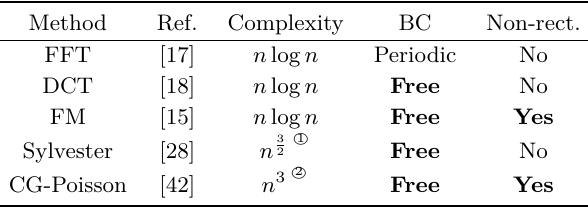
Comparison of five existing fast and accurate surface normal integration methods based on three criteria: their algorithmic complexity w.r.t. the number n of pixels inside the computational domain Ω (the lower the better), the type of boundary condition (BC) they use (free boundaries are expected to reduce bias), and the permitted shape of Ω (handling non-rectangular domains can